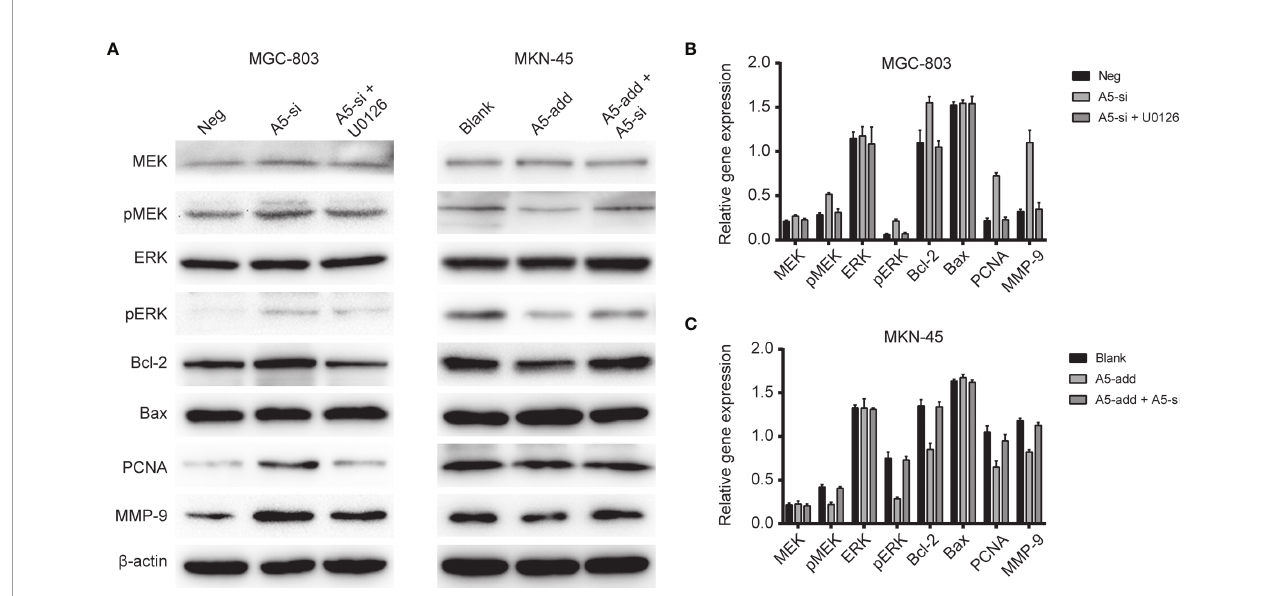
FIGURE 5 | ANXA5 regulates gastric carcinoma cell proliferation and metastasis via the MAPK/ERK pathway. Western blot was used to detect the expression of pMEK and pERK expression which are the biomarkers of the MAPK/ERK signal pathway. With the down-regulation of ANXA5, the expression of total MEK and ERK was not altered, while pMEK and pERK level was enhanced signi fi cantly ( P < 0.0001). On the other hand, with the ANXA5 protein added to the cell culture supernatant, pMEK and pERK level was reduced (A) To make sure that ANXA5 depends on this pathway, the MEK inhibitor U0126 20 m M was added to the A5-si cells to neutralize the increase of pMEK and pERK; on the other hand, the A5- add cells were transfected with the ANXA5 siRNA to offset the decrease of pMEK and pERK. At the same time, Bcl-2, PCNA, and MMP-9 restored to the original level which demonstrated that ANXA5 in fl uenced the gastric cancer cells through MAPK/ERK pathway. (B) The statistics of gene expression in MGC-803 cells. (C) The statistics of gene expression in MKN-45